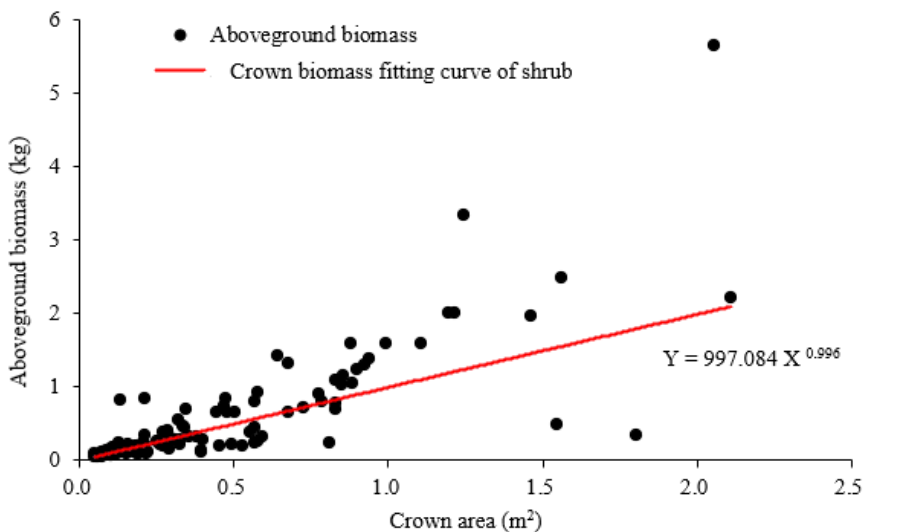
Figure 5. Optimal fitting models of the AGB and crown area of shrub in a sample area of Gobi Desert.